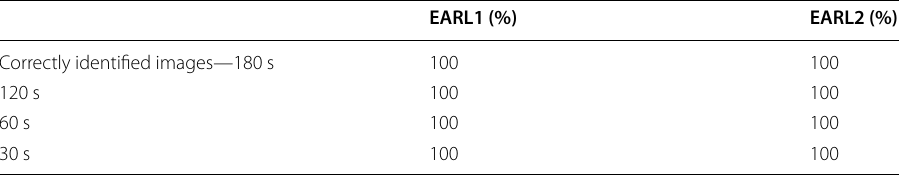
Table 5 Accuracy of the second CNN applied to images reconstructed with different scan durations acquired on the Biograph Vision